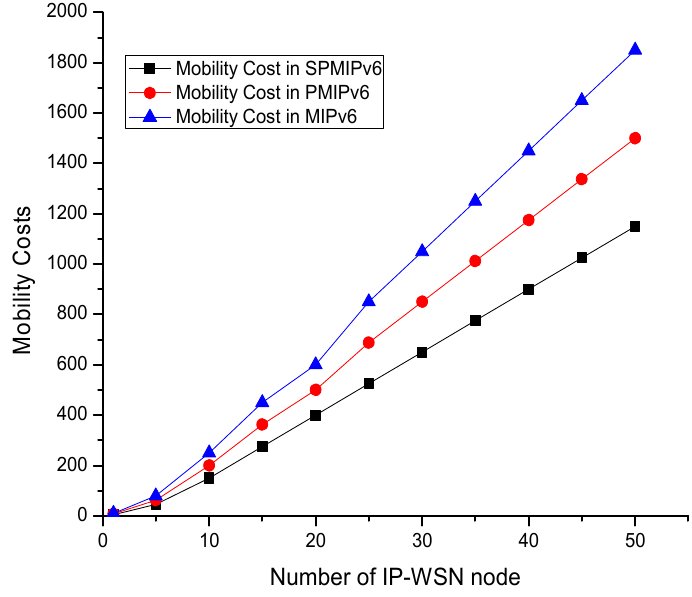
Figure 17. Number of IP-WSN nodes vs. Mobility